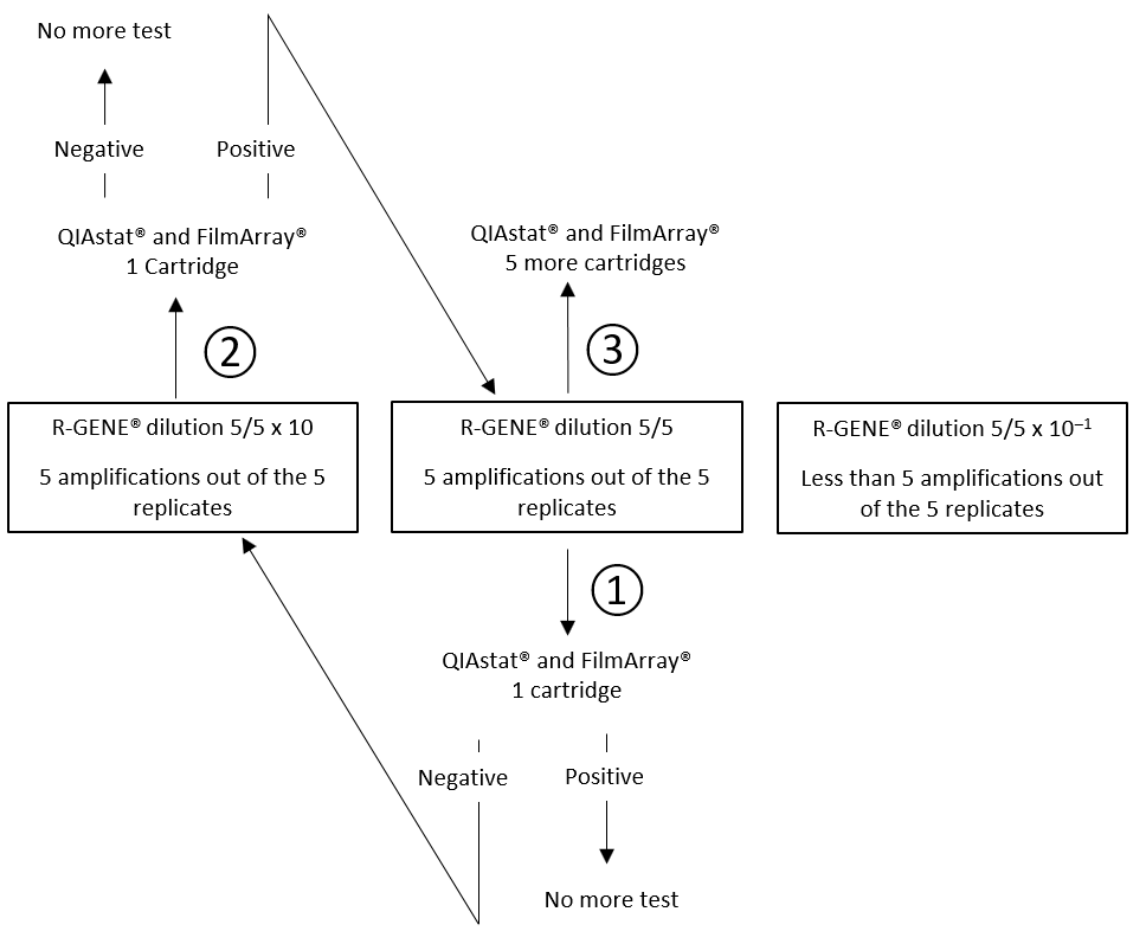
Figure 1. Strategy for assessing the detection of low viral and Mp loads, from step 1 to 3, using CSF diluted pool with positive results with R-GENE ® in 5 replicates and tested by two point-of-care syndromic PCR QIAstat Dx ® (QS) and FilmArray ® (FA).